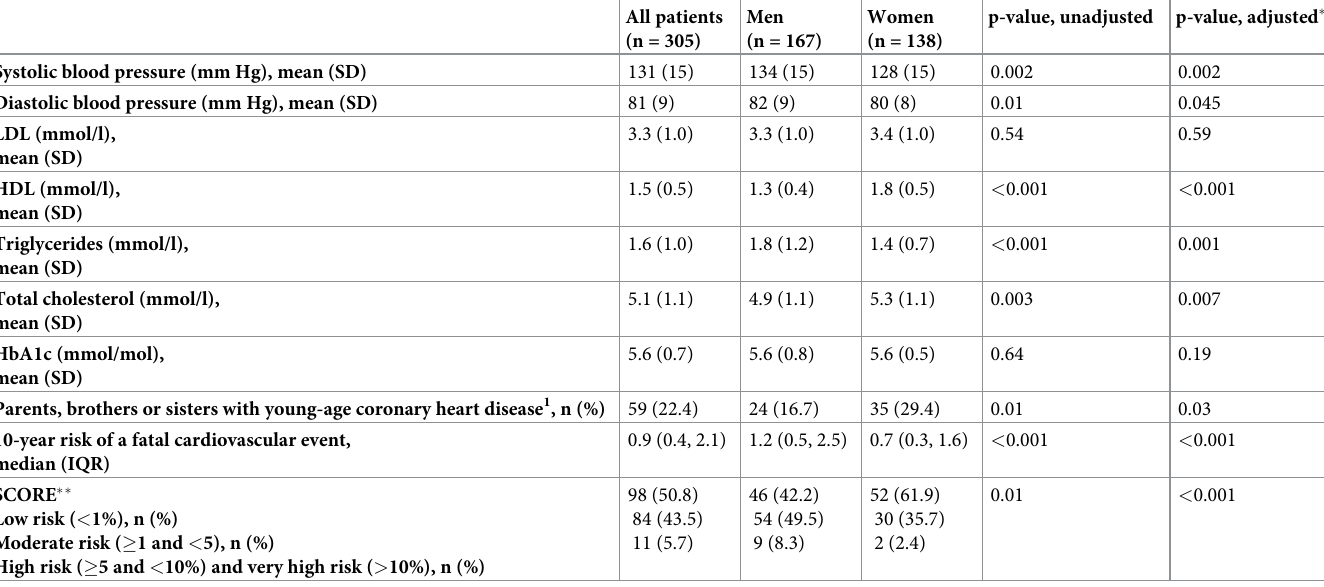
Table 4. Cardiovascular risk